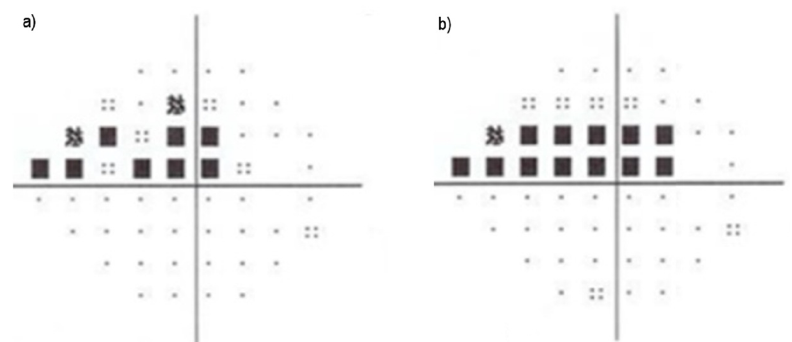
Figure 4. Visual field diagrams. ( a ) shows the initial field of view; ( b ) shows the posterior field of view, illustrating the worsening of glaucoma. The lightest dots represent islands of vision, and the squares with a gradation of gray (partial visual loss) to black (complete loss of vision) that increase in number as the disease progresses.